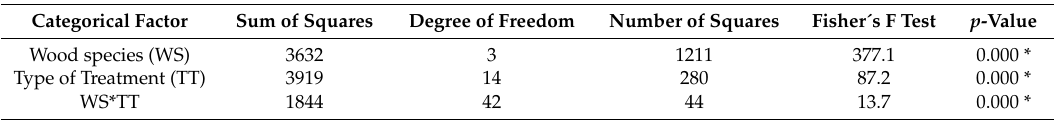
Table 4. Factorial ANOVA analyses of selected factors affecting the Δ E* values of treated wood surfaces after 320 h of accelerated ageing.